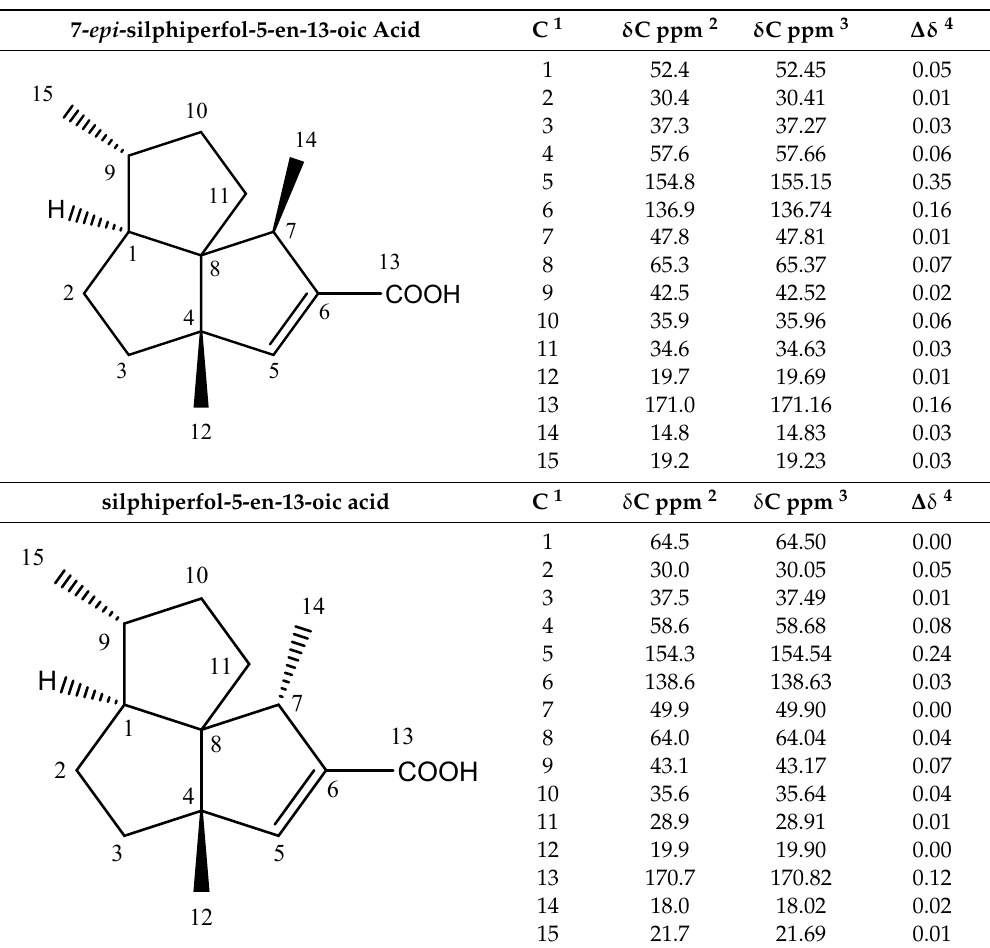
Table 2. 13 C NMR data (400 MHz, CDCl 3 ) of compounds 152 and 153.